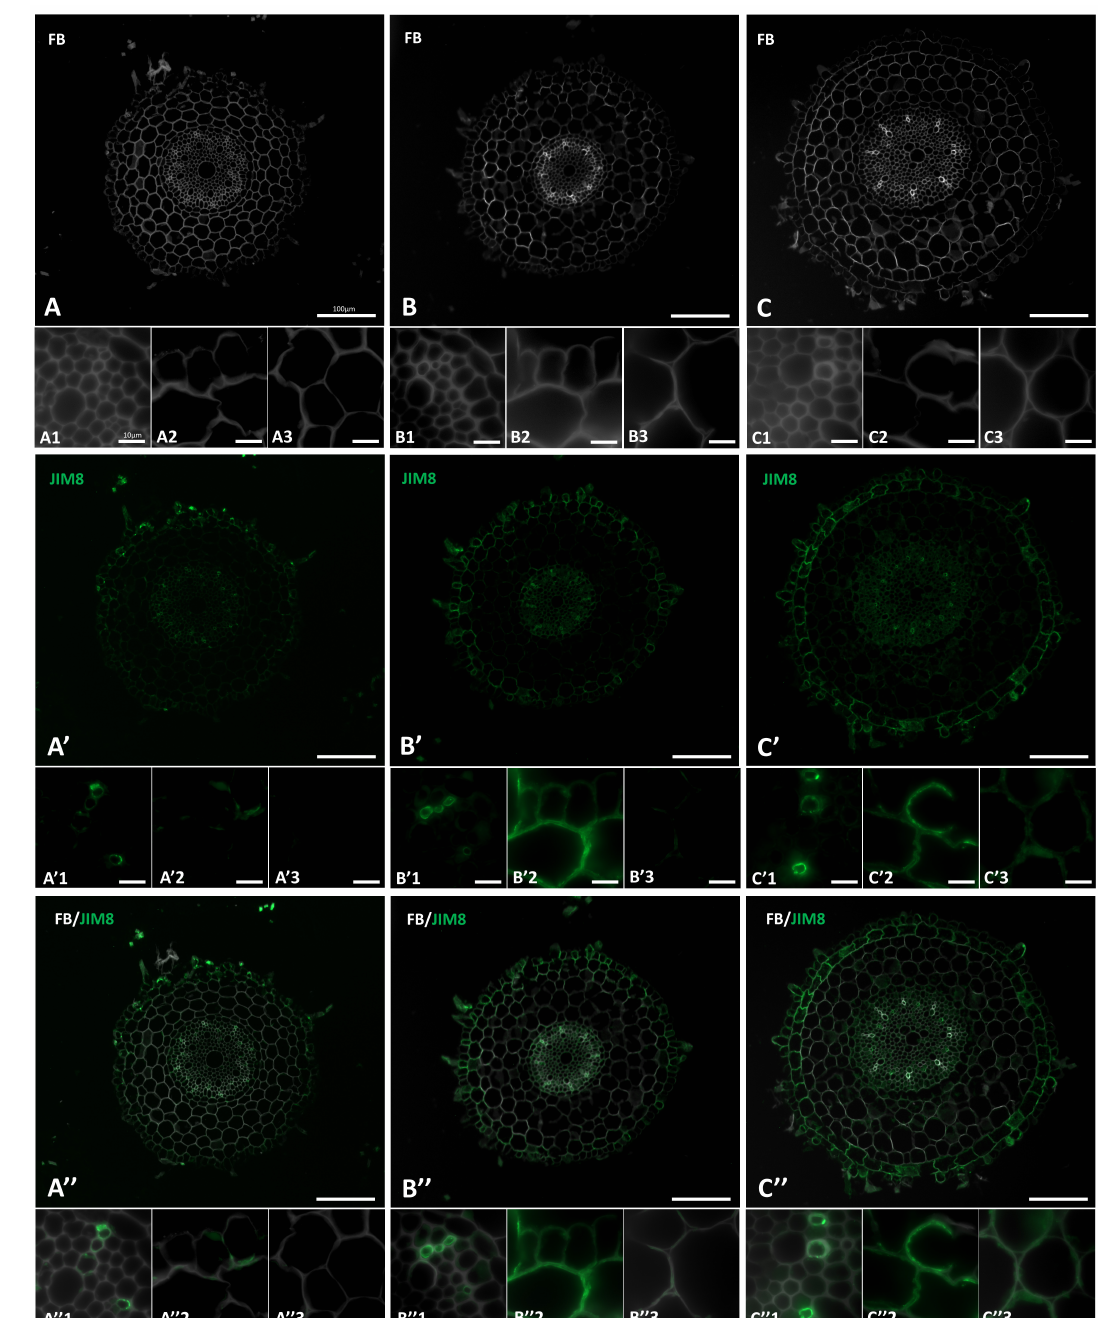
(Figure 5B (cid:48) 1,C (cid:48) 1,B (cid:48)(cid:48) 1,C (cid:48)(cid:48) 1). An increase in the intensity of fluorescence signal of JIM13 was observed in the walls of rhizodermal and exodermal cells (Figure 5B (cid:48) 2,B (cid:48)(cid:48) 2,C (cid:48) 2,C (cid:48)(cid:48) 2) as well as in the walls of cortex cells (Figure 5B (cid:48) 3,C (cid:48) 3,B (cid:48)(cid:48) 3,C (cid:48)(cid:48) 3) in “salt-stressed” roots compared to the control (Figure 5A (cid:48) 3).